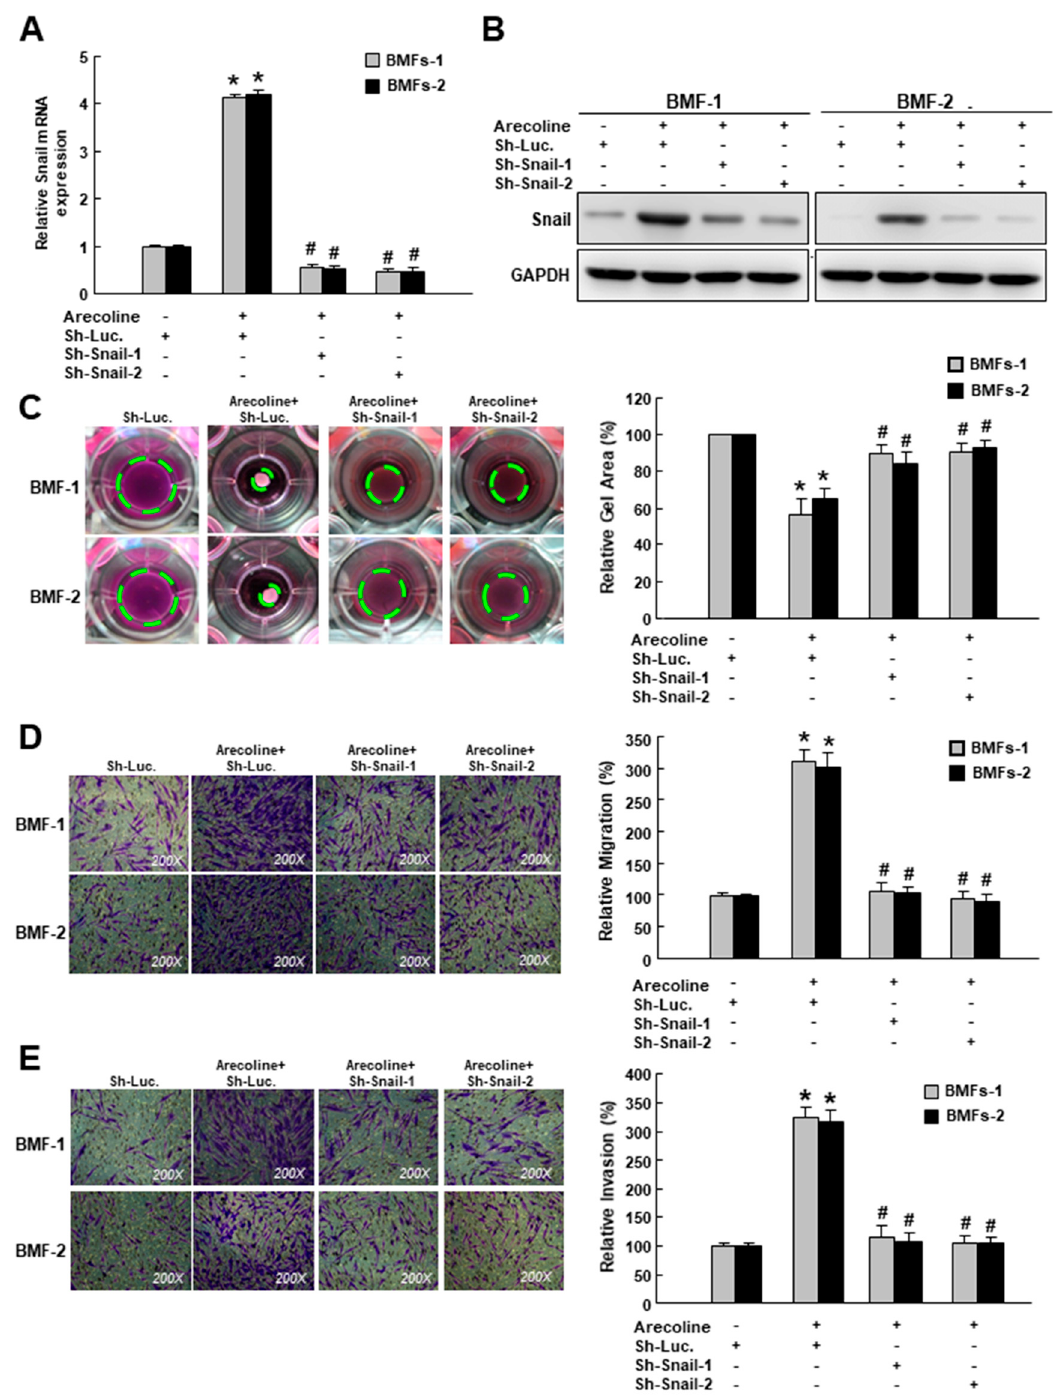
Figure 2. Snail is essential for arecoline-induced myofibroblast transdifferentiation. ( A ) Relative gene and ( B ) protein expression levels of Snail in arecoline-treated BMFs with sh-Luc or sh-Snail; myofibroblast activities, including ( C ) collagen gel contraction, ( D ) migration and ( E ) invasion abilities of arecoline-treated BMFs with sh-Luc or sh-Snail. The area of the gel is indicated by the green dotted line. Results are means ± SD of triplicate samples from three experiments. * p < 0.05 compared to sh-Luc group. # p < 0.05 compared to arecoline + sh-Luc group.